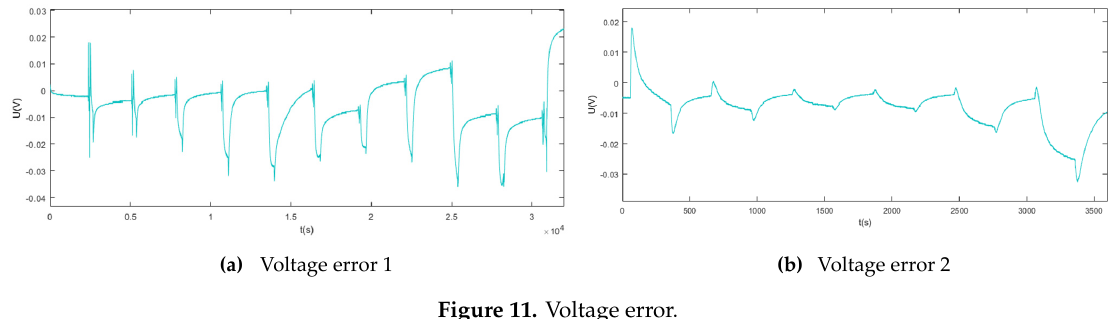
Figure 11. Voltage error.